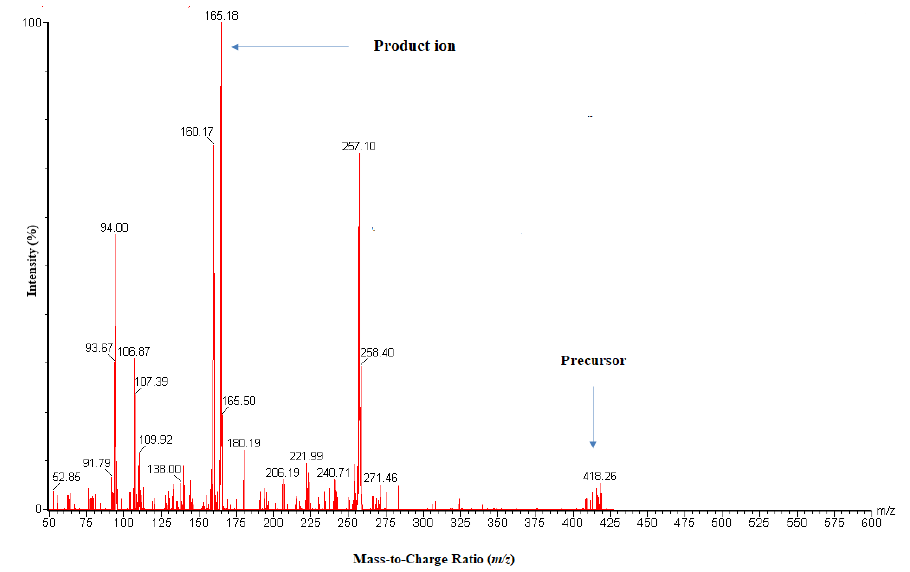
Figure 2. Typical representation of precursor to product ion spectra of PX- in ESI-positive ionization mode. Table 1. Mass optimization parameters for PX and gifitinib (IS).